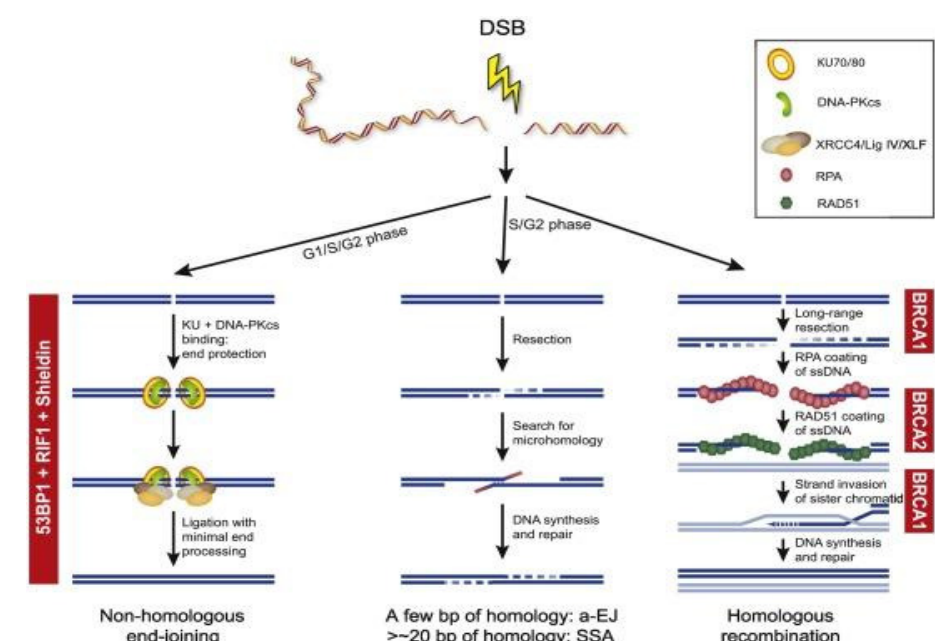
Figure 1. Overview of the different DSB repair pathways. End resection is the essential step for the choice between cNHEJ and HR, a-EJ, and SSA. The availability of a sister chromatid will direct HR. Different steps during HR are dependent on BRCA1 and BRCA2. NHEJ is dependent on the activity of 53BP1, RIF1, and the Shieldin complex (REV7, SHLD1, SHLD2, and SHLD3).